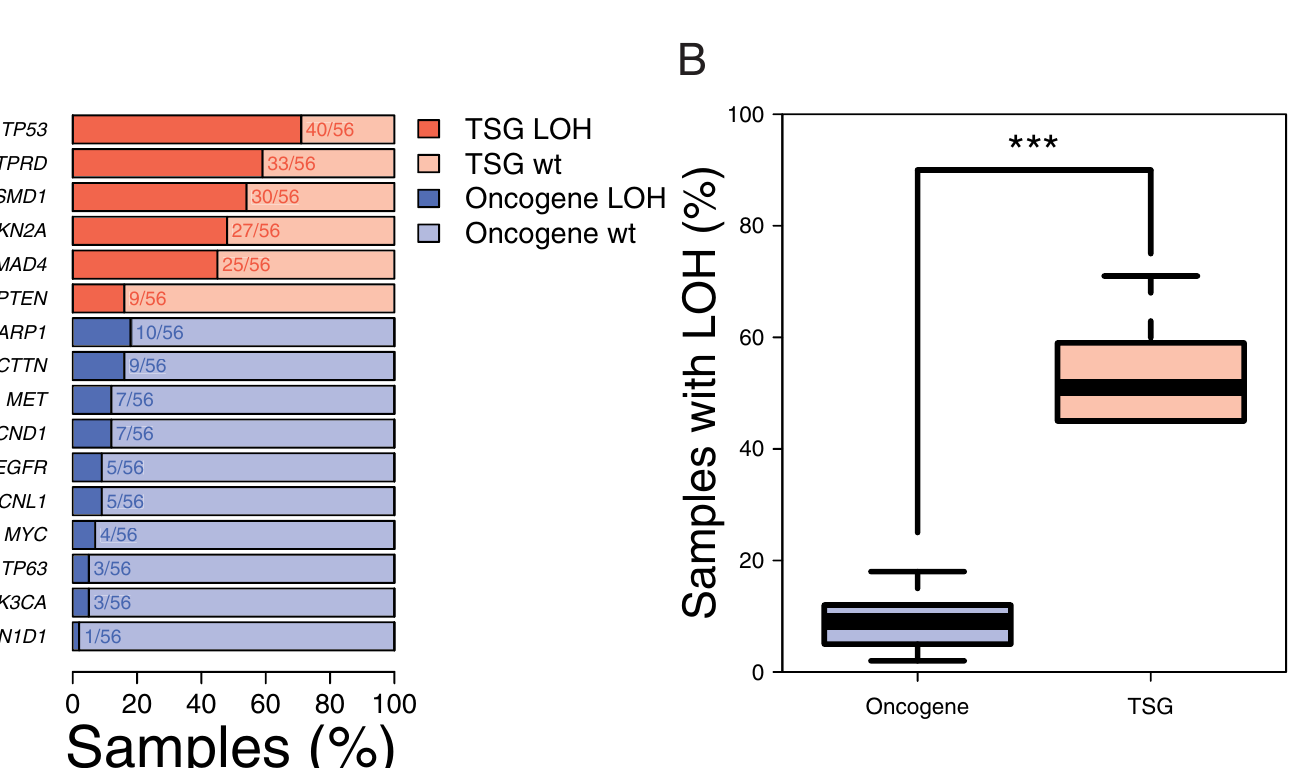
Fig 3. Loss of heterozygosity events are more common in tumor suppressor genes. (A) The percentage of HNSCC samples with LOH per TSG (dark red) and OG (dark blue). HNSCC TSG and oncogenes (OG) are as reported by Leemans et al. Light colors represent the percentage of samples without LOH (wt). Fraction of samples with LOH are indicated by numbers and dark colors. (B) Boxplot representation of the percentage of HNSCC tumor samples with LOH in any TSGs or OGs as shown in Fig 3A. TSGs are enriched for LOH events ( p < 0.005).